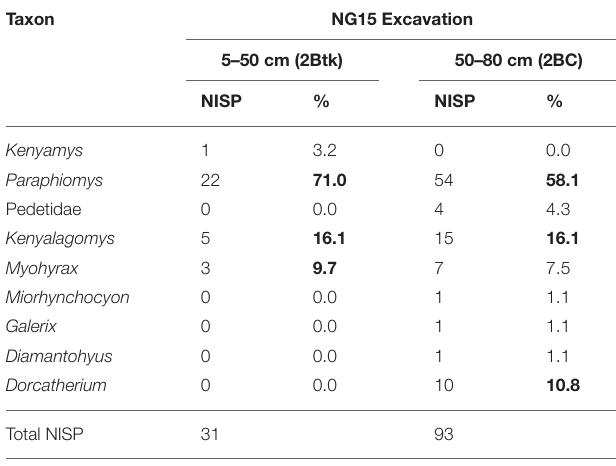
TABLE 4 | Faunal composition of the excavated NG15 site by depth interval, omitting surface